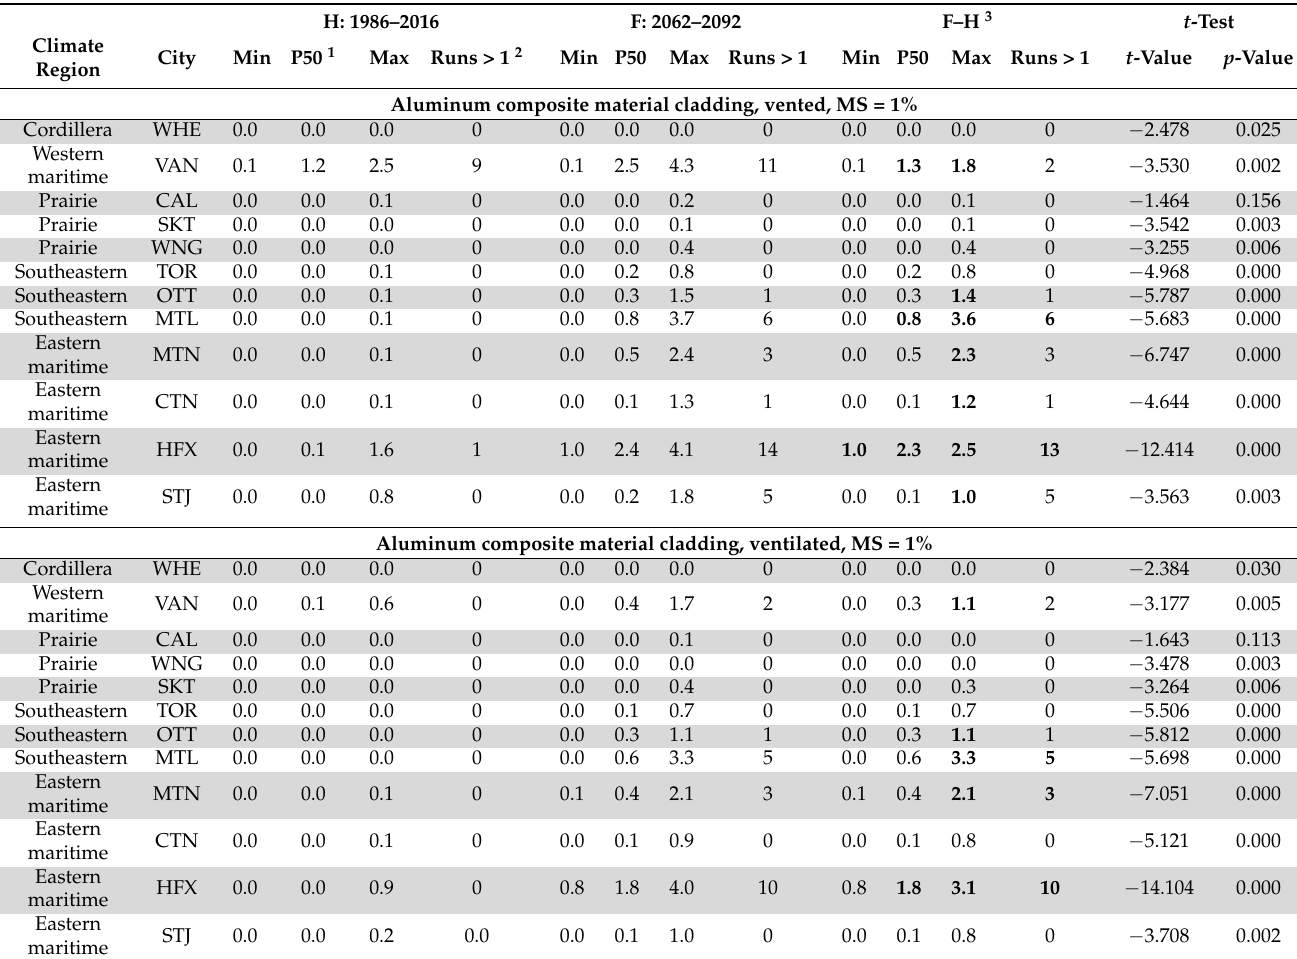
Table 5. Summary statistics and projected changes in mold growth index in the case of aluminum composite cladding with a moisture source of